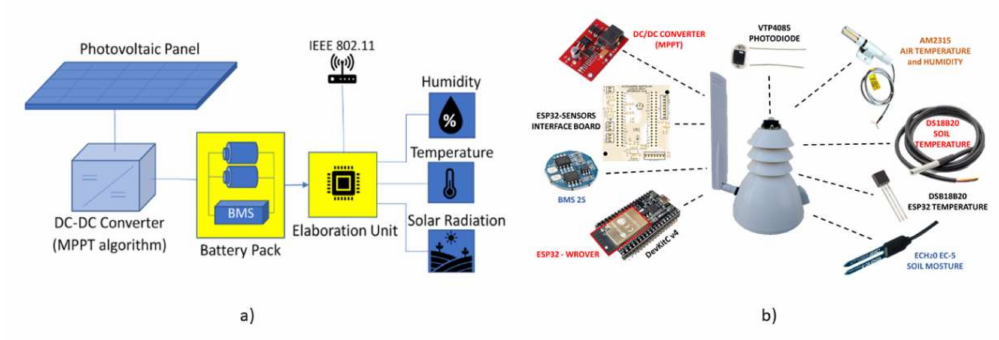
Figure 3. Representation of the developed sensor node for agriculture application. ( a ) Block diagram. ( b ) Representation of all the subsystems that are included in the sensor node. In the center of the image there is the waterproof case equipped with an external antenna. On the left side the electronic boards, while on the right side all the sensors that compose the “Sensors